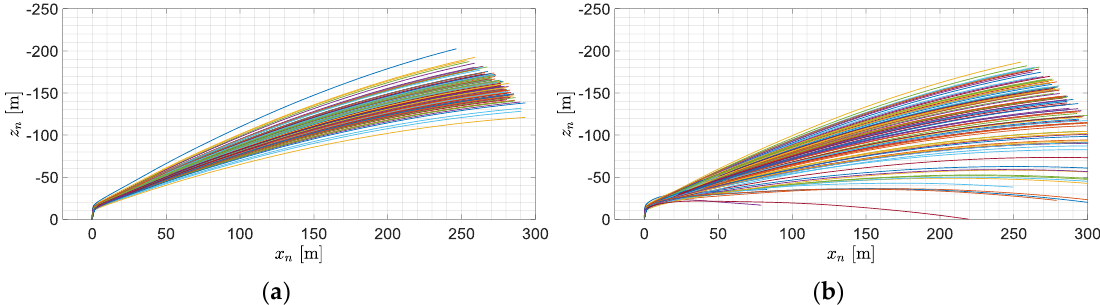
Figure 10. Projectile trajectories projections on O n x n z n for various initial roll rate standard deviations. ( a ) 10 ◦ / s; ( b ) 60 ◦ / s.